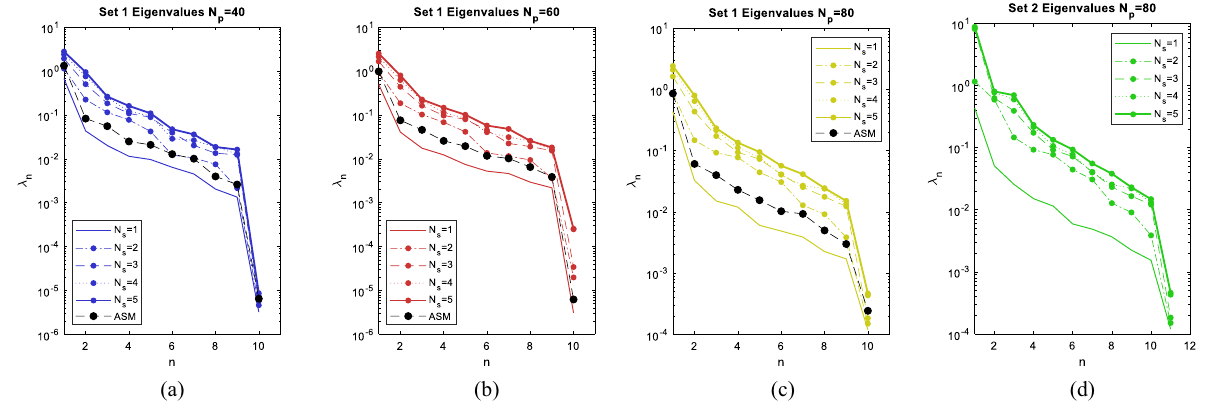
Figure 3. Eigenvalues approximation for ( a ) Set 1 for N p = 40 , ( b ) Set 1 for N p = 60 , ( c ) Set 1 for N p = 80 ( d ) Set 2 for N p = 80 .